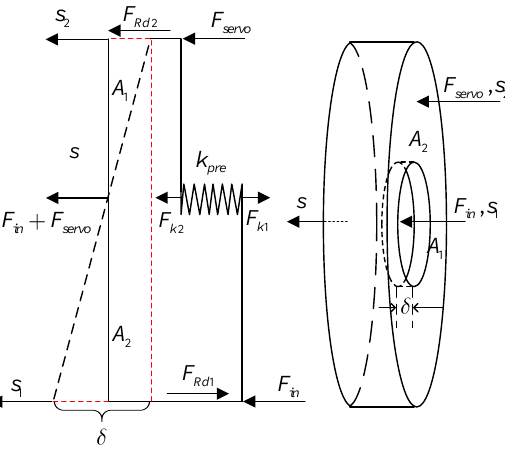
Figure 6. E-Booster kinematic model.